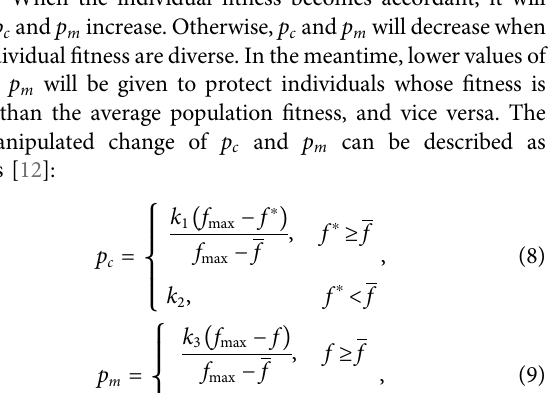
FIGURE 1 | Schematic diagram for the extraction and inoculation